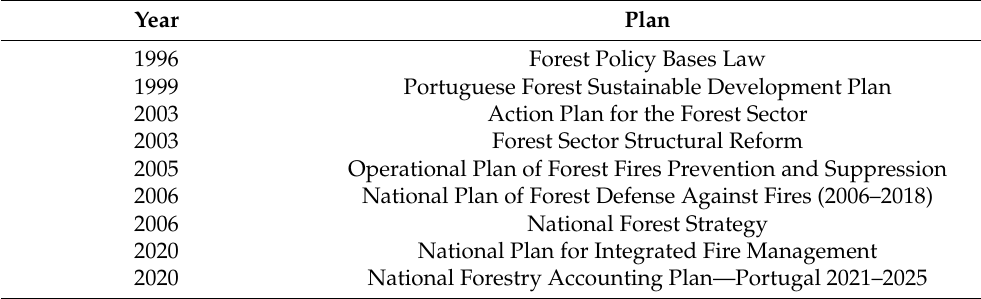
Table 5. Portuguese forest strategies (adapted from